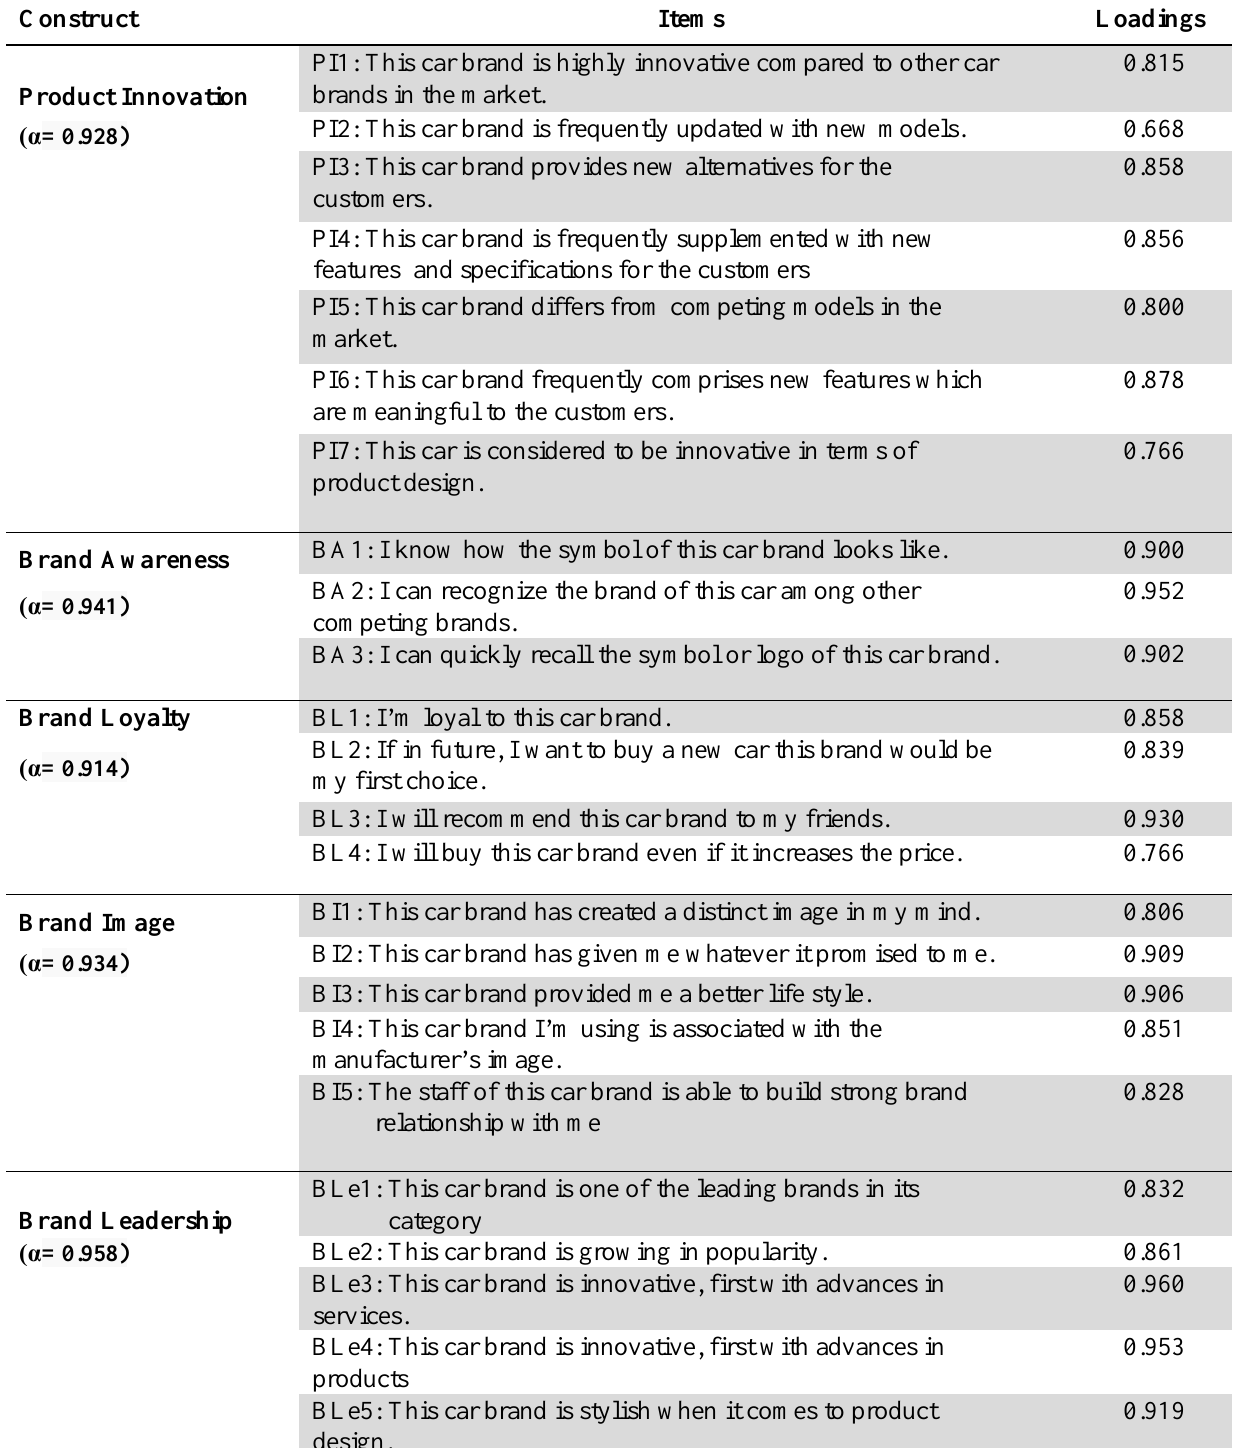
Factor Analysis Results and Cronbach’s Alpha Values